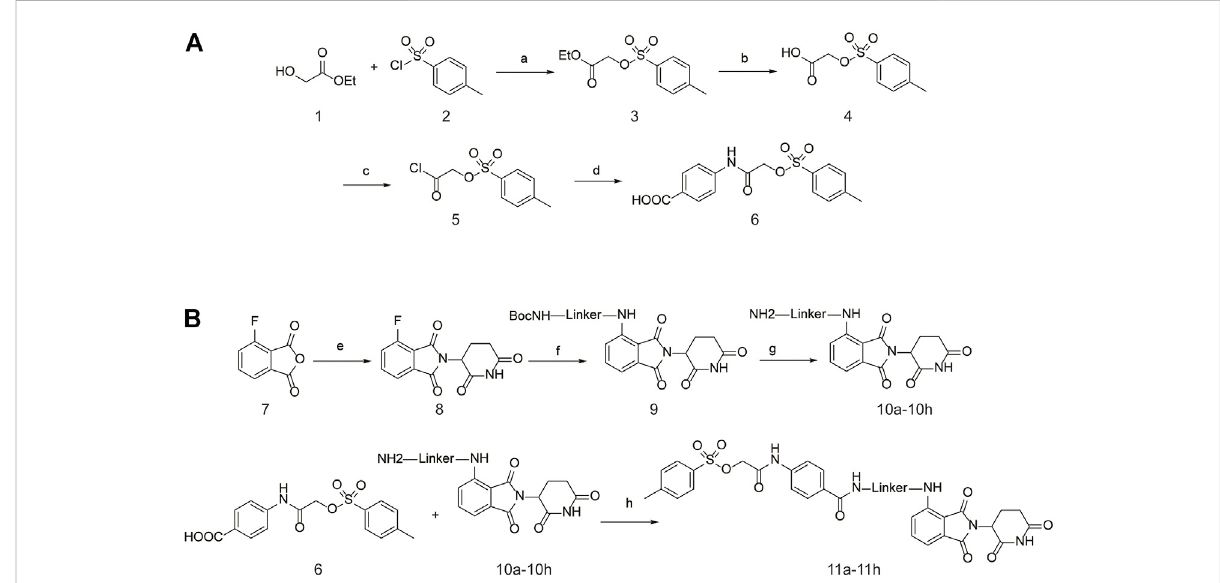
FIGURE 3 Synthetic route of PROTACs. (A) Synthesis of S3I-201 analogs. (B) Synthetic of PROTACs. Reagents and conditions: (a) THF, 0 ° C, 3 h; (b) 5% NaOH aq, EtOH, rt, 3 h; (c) SOCl 2 , 80 ° C, re fl ux, 2 h; (d) THF, Et 3 N, 0 ° C, overnight, rt; (e) 3-Aminopiperidine-2,6-dione hydrochloride, CH 3 COONa, CH 3 COOH, 100 ° C, 16 h; (f) BocNH-Linker-NH 2 , DIPEA, DMF, 80 ° C; (g) DCM, CF 3 COOH, rt, 2 h; (H) HATU, DIPEA, DCM, rt, 12 h.